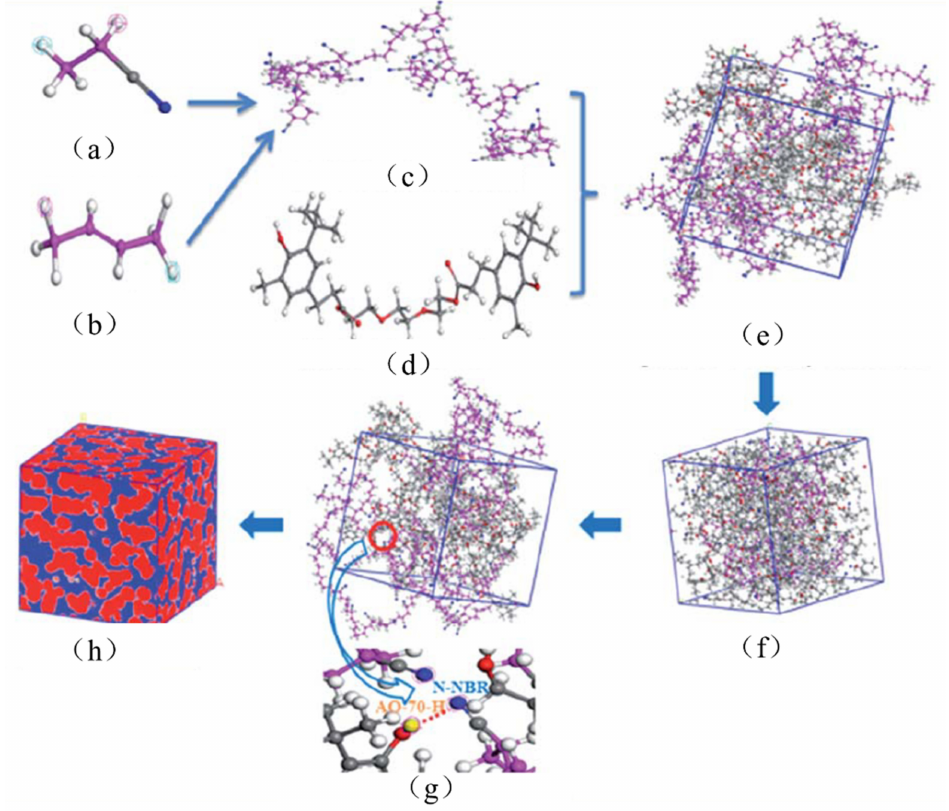
Figure 8. Models for molecular dynamics simulation of AO-70/NBR rubber composites (blue sphere represents N atom, red sphere represents O atom, grey sphere represents H atom, pink sphere and dark grey sphere connects with N atom represent C atom, and red dashed line represents H-bond): ( a ) A Acrylonitril repeating unit; ( b ) A Butadiene repeating unit; ( c ) NBR polymer chain; ( d ) AO-70 molecule; ( e ) 3D cubic cell with periodic boundary conditions; ( f ) Molecular dynamics simulation; ( g ) H-bonds in AO-70/NBR and ( h ) Free volume analysis [40].